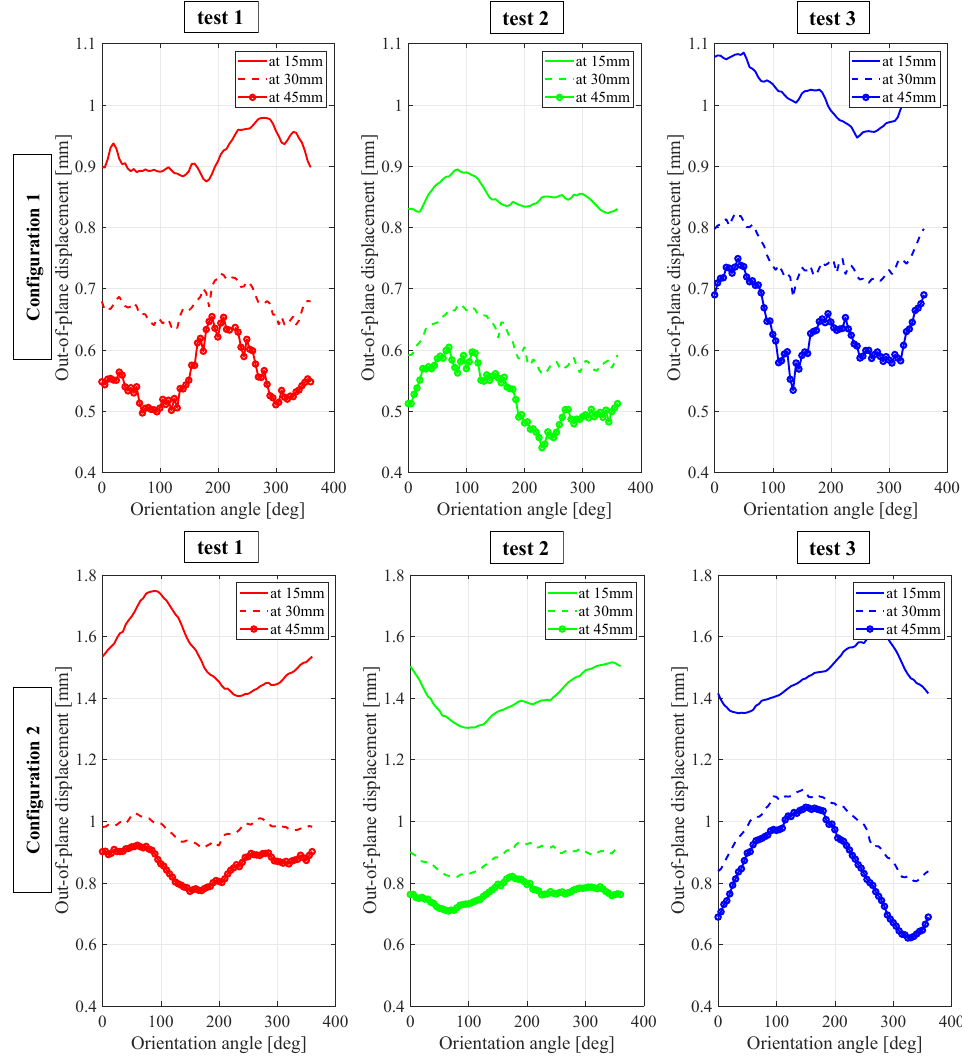
Figure 8. The out-of-plane-displacement of points placed on a circle of a given radius (15 mm, 30 mm or 45 mm) from the impact center as a function of their orientation angle (the 0 ◦ angle corresponds to a point placed horizontally at the right side of the impact hole and increases counterclockwise) for the three tests of configurations 1 and 2 and shows the FSP anisotropic effect on plate